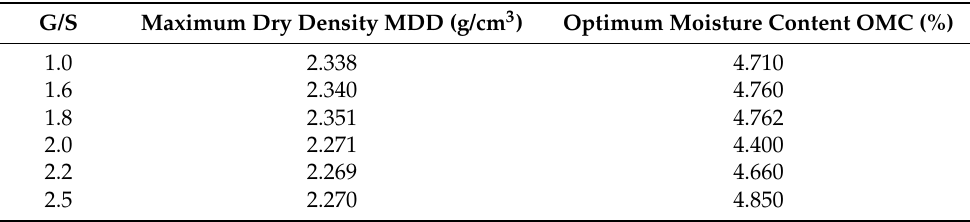
Table 2. The optimal moisture content (OMC) and maximum dry density (MDD) results for the five different gradations representing different levels of particle breakage.